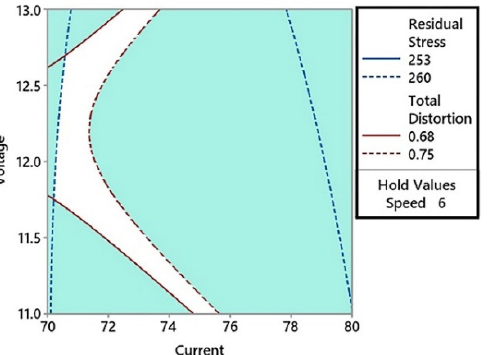
Figure 10. The overlaid contour plot of the total distortion and residual stress with a welding speed of 6 mm/s. of 6